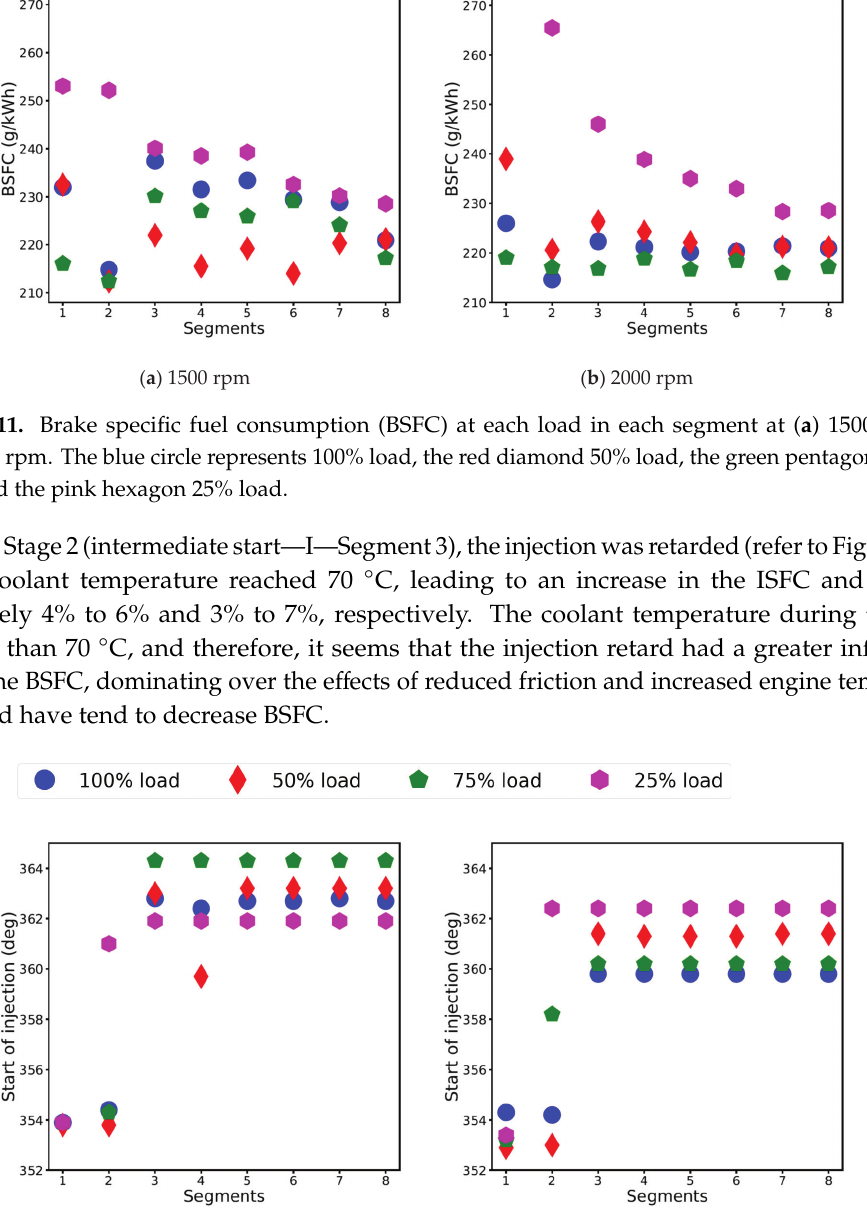
Figure 12. Start of injection at each load in each segment at ( a ) 1500 and ( b ) 2000 rpm. The blue circle represents 100% load, the red diamond 50% load, the green pentagon 75% load and the pink hexagon 25% load.